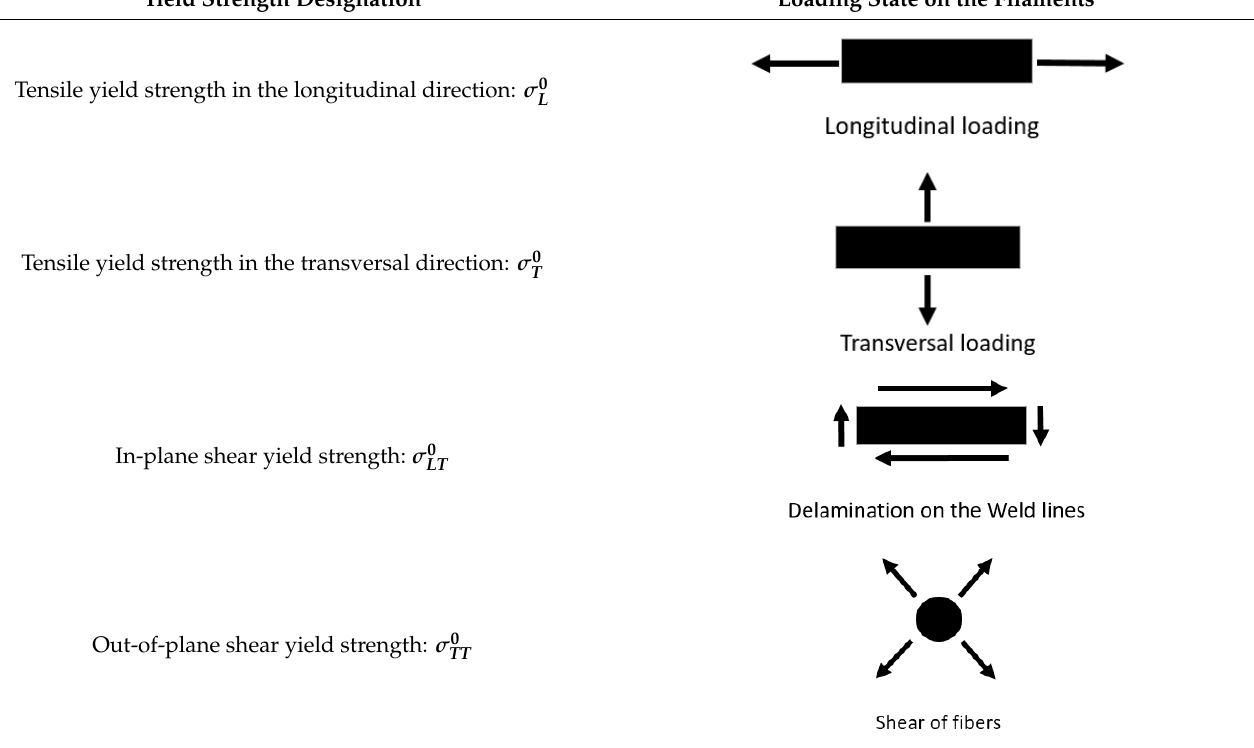
In-plane shear yield strength: σ 0